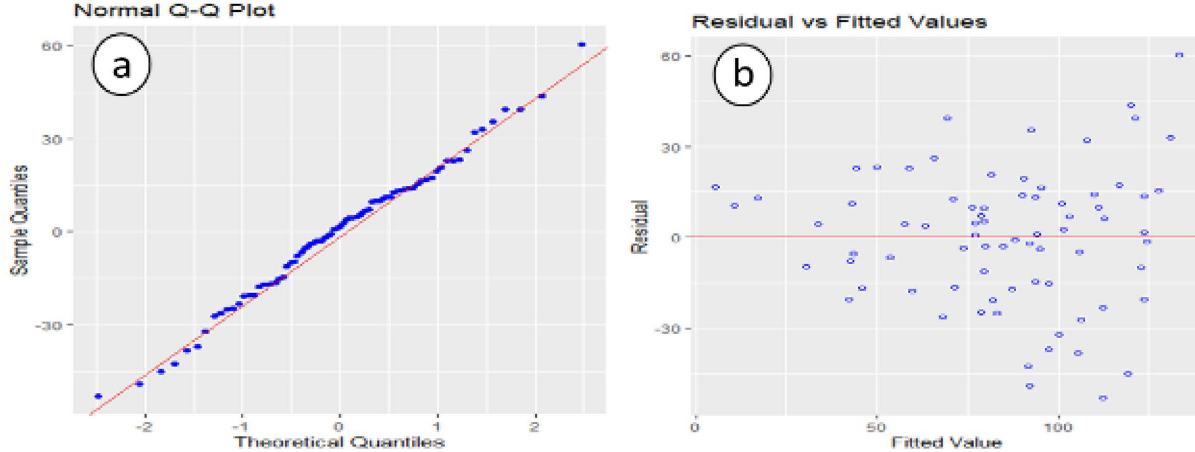
Figure 7. ( a ) Residuals normality plot, ( b ) residuals equality of variances plot.